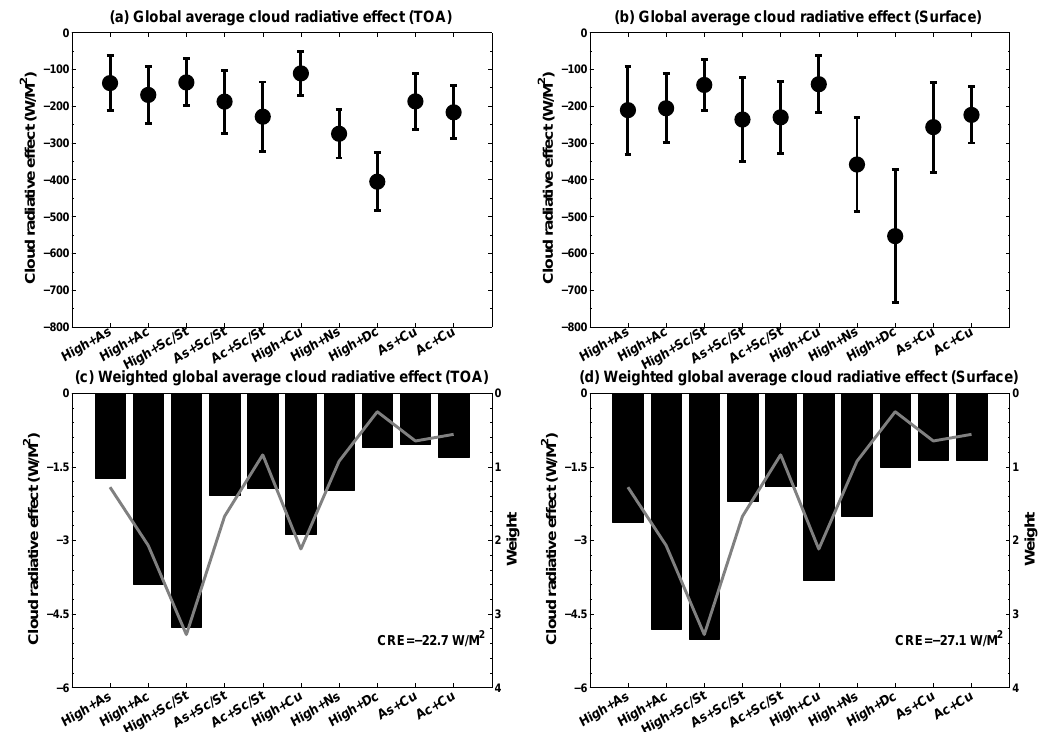
Figure 7. The global average instantaneous net cloud radiative effect and weighted instantaneous net cloud radiative effect for different multilayered cloud types at the TOA and surface only during daytime. The gray line presents the global average frequency of occurrence of each cloud type only during daytime (that is, weights). The total weighted instantaneous net cloud radiative effects of 10 multilayered cloud systems are also shown in (c) and (d) : TOA ( − 22.7Wm − 2 ) and surface ( − 27.1Wm − 2